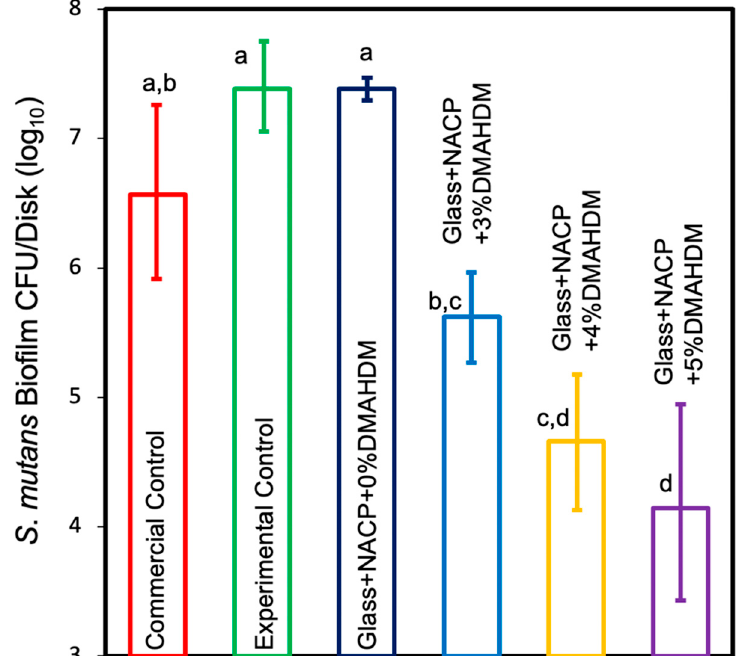
Figure 6. Colony-forming unit (CFU) counts for 2-day biofilms on resin cement disks (mean ± SD; n = 4). Adding 4% and 5% DMAHDM + NACP to resin cement significantly reduced CFU count for Streptococcus mutans compared to the commercial and experimental controls ( p < 0.05). The incorporation of 3% DMAHDM + NACP in resin cement significantly reduced CFU count for